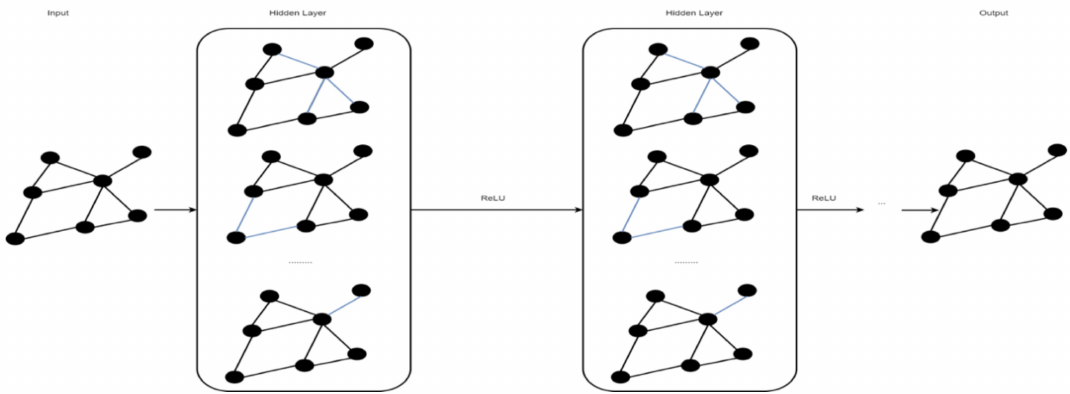
Figure 5. A graph convolutional network (GCN) (adopted from